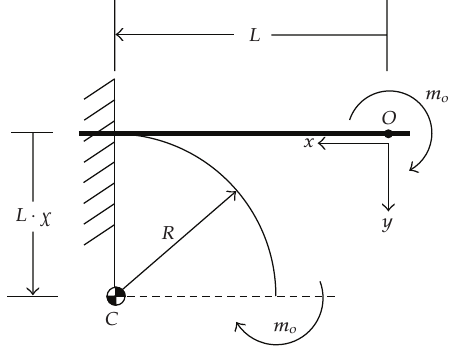
Figure 1: Horizontal cantilever rod inflected by a constant bending couple at its